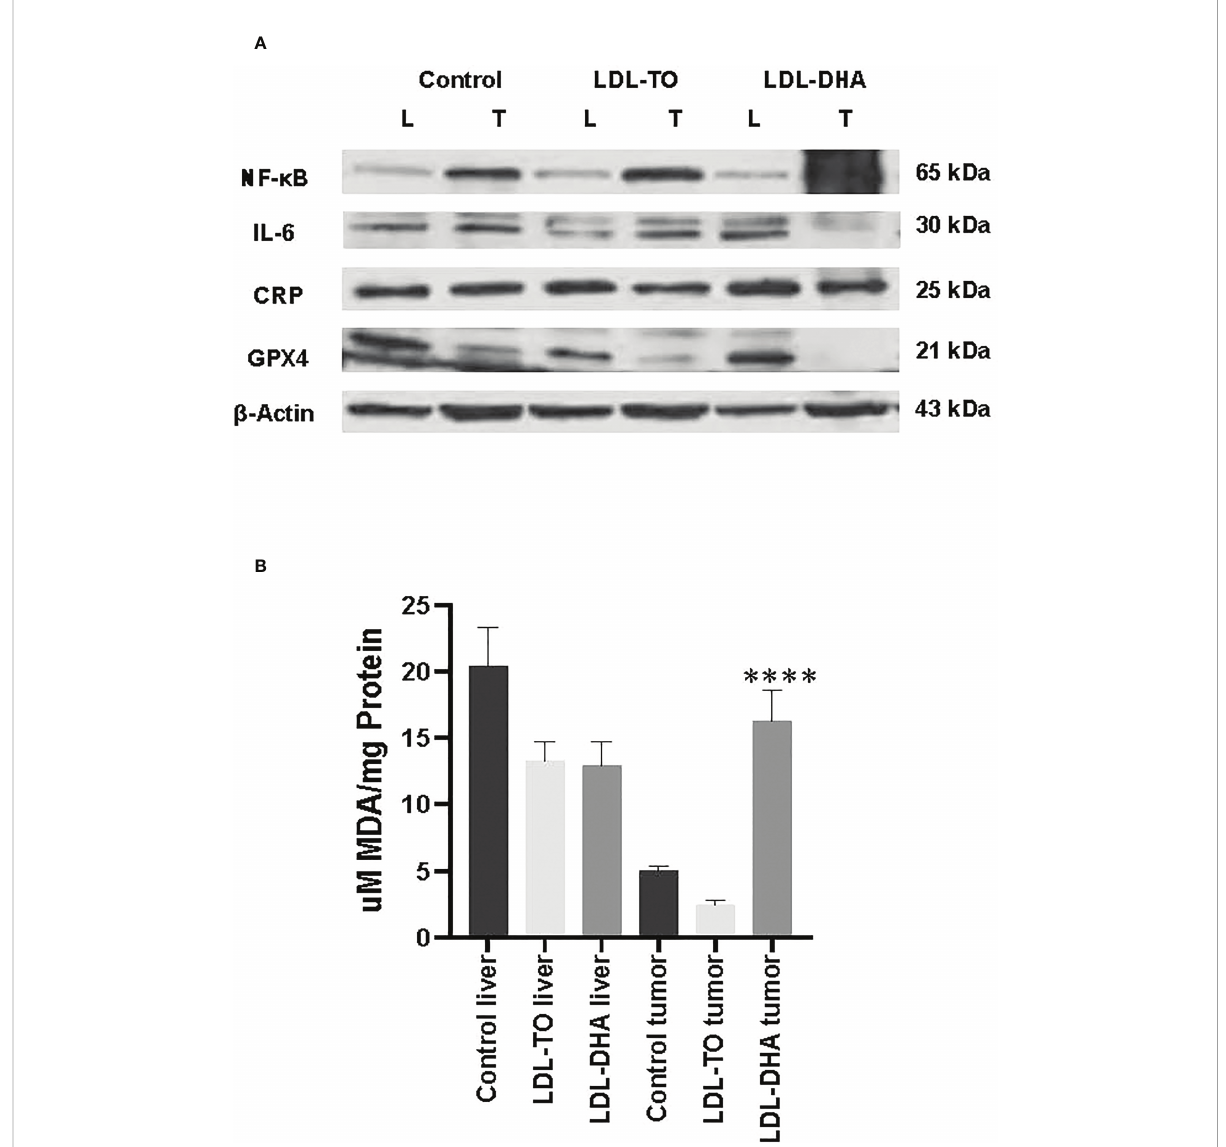
FIGURE 6 In fl ammation and lipid peroxidation markers in LDL nanoparticle treated tumors. (A) Protein expression levels of in fl ammatory response marker and glutathione-peroxidase 4. Protein expression of hepatic nuclear factor- ĸ b (NF- ĸ b ), interleukin-6 (IL-6) C reactive protein (CRP) and